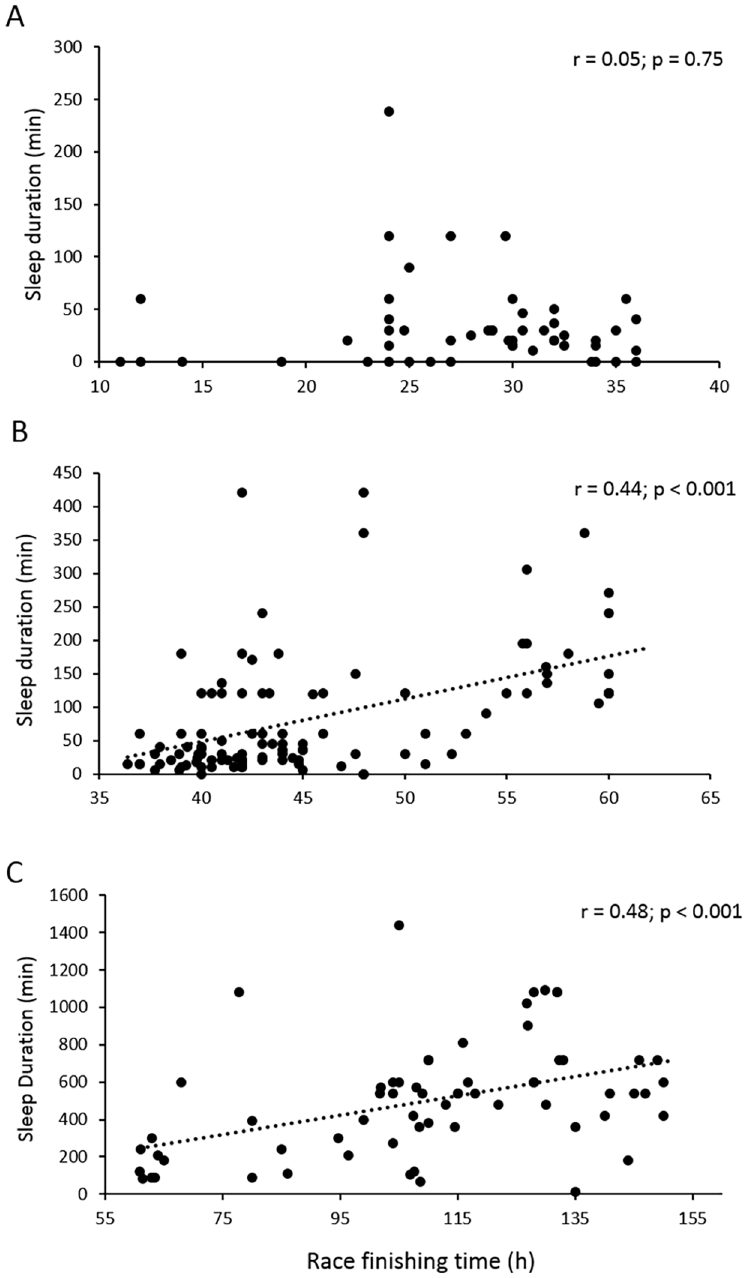
Fig 4. Correlations between sleep duration and race time for races shorter than 36 h (panel A), races lasting between 36 and 60 h (panel B) and races longer than 60 h (panel C). No correlation was found between sleep duration and finish time for races (cid:20) 36 h (r = -0.05; p = 0.75), yet sleep duration and finish time were correlated for races lasting 36– 60 h (r = 0.48; p < 0.01) or > 60 h (r = 0.44; p <